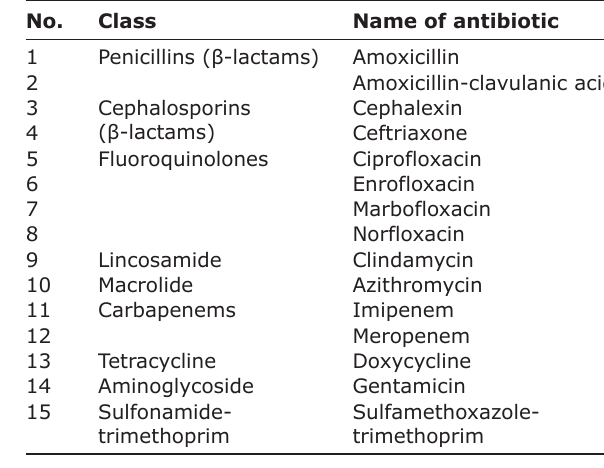
Table-2: Antimicrobial drugs used for susceptibility test of bacterial species isolated from uterine contents in pyometra bitches.